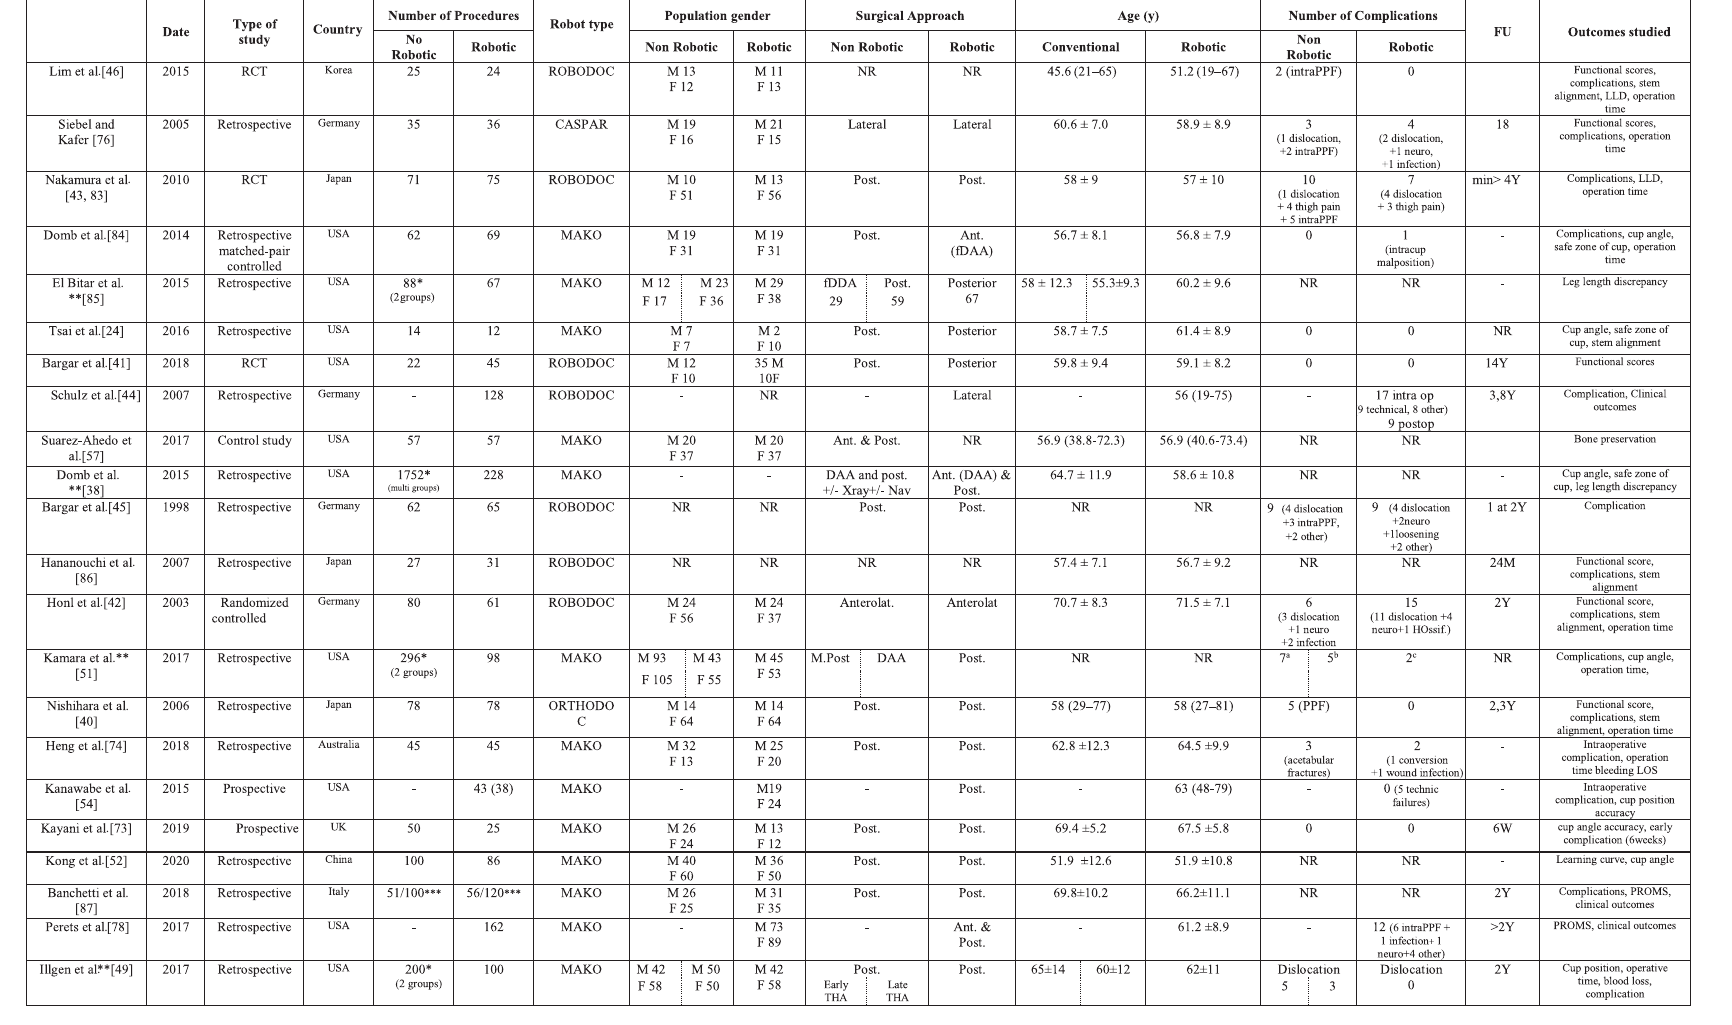
* Sum of all procedures without the use of the robot in studies with more than two groups of comparison including 2 techniques assistance or approach of non-robotic THA. ** Relating studies with multi-subgroups comparing different THA procedures without robot with a group with a robotic assistance. *** Respondent ’ s patient at the follow-up. a 3 intraoperative (femoral fractures) + 1 early dislocation + 4 revisions (1 femoral for the failure of osseointegration, 1 LLD, 1 wound infection, 1 delayed infection at 1 Y;